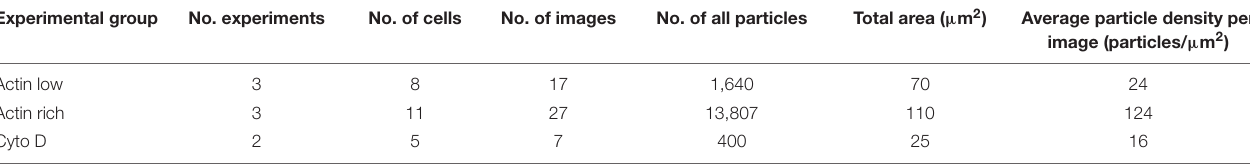
TABLE 1 | Summary of scanning transmission electron microscopy (STEM) data used for label distribution analyses. Experimental group